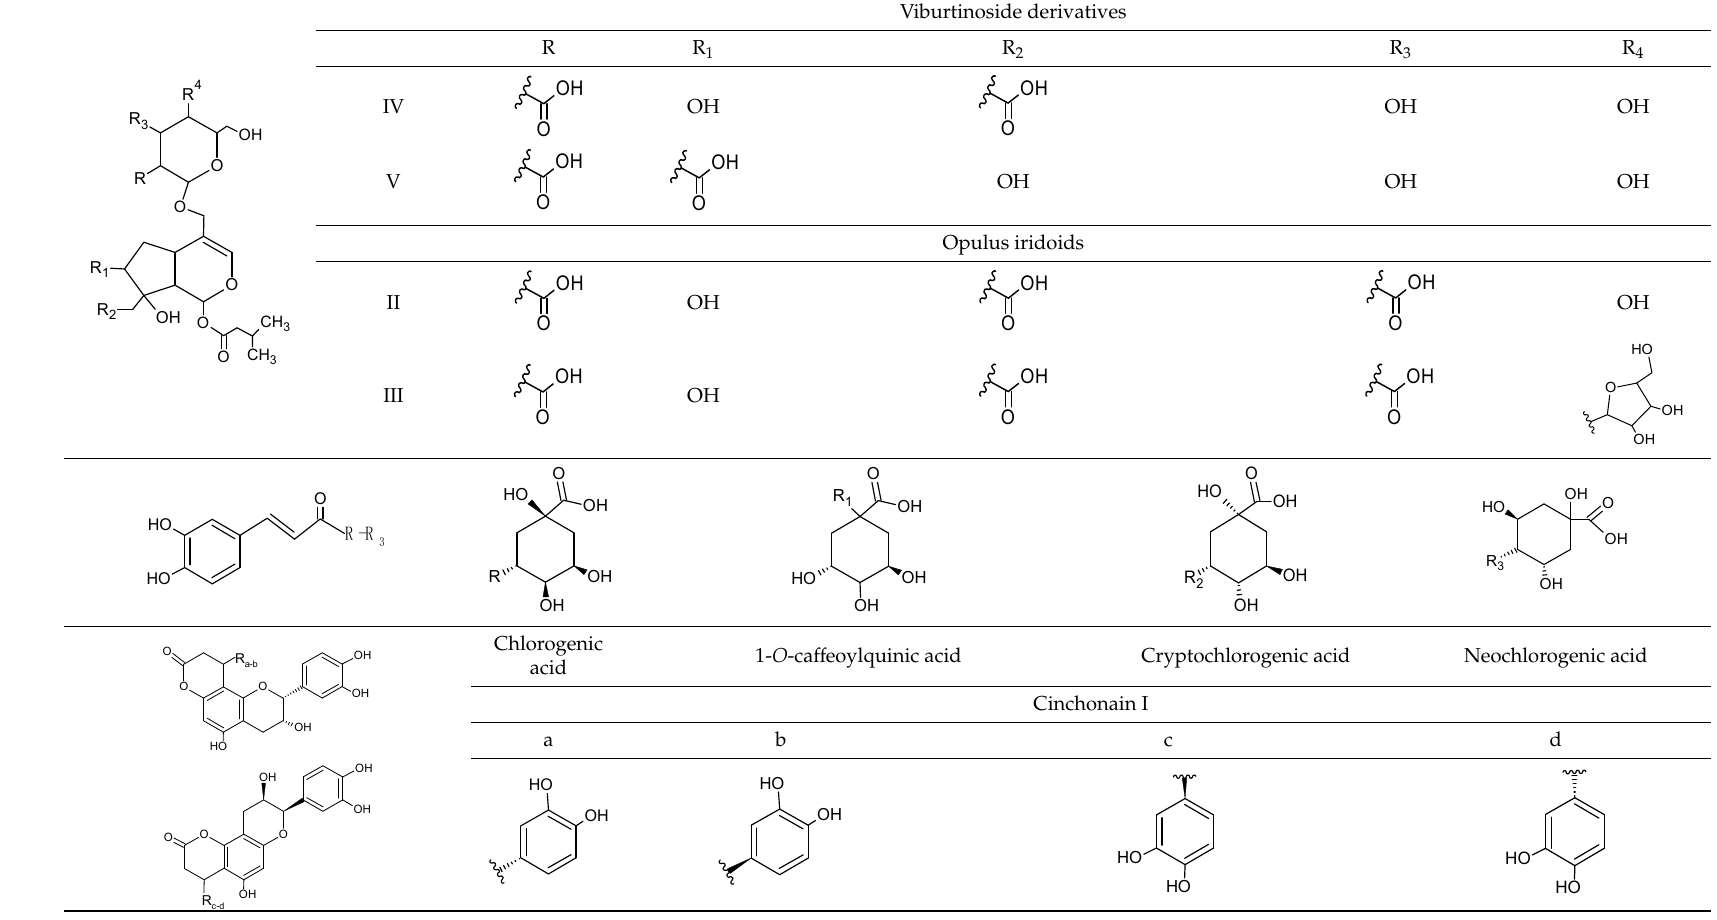
Table 3. Structures of some bioactive compounds identified in guelder rose berry pomace extracts.